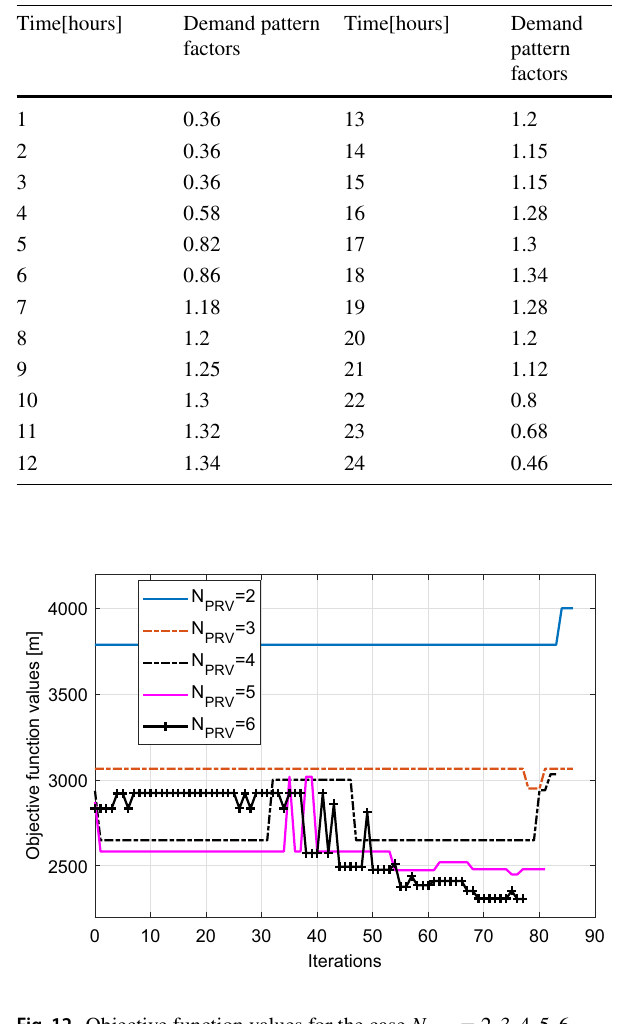
Fig. 12 Objective function values for the case N PRV =